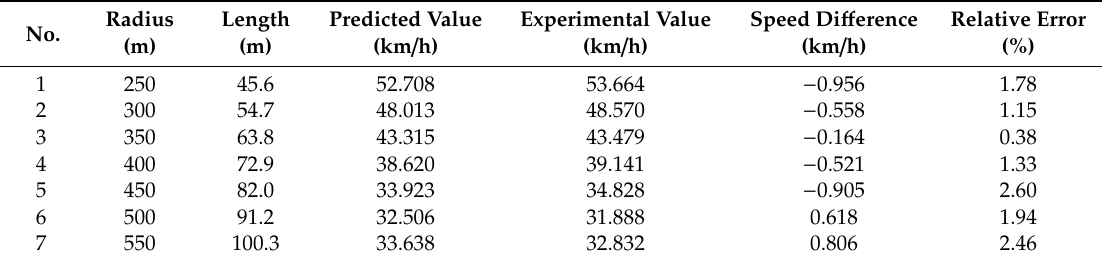
Table 7. Comparison of predicted and experimental speed.